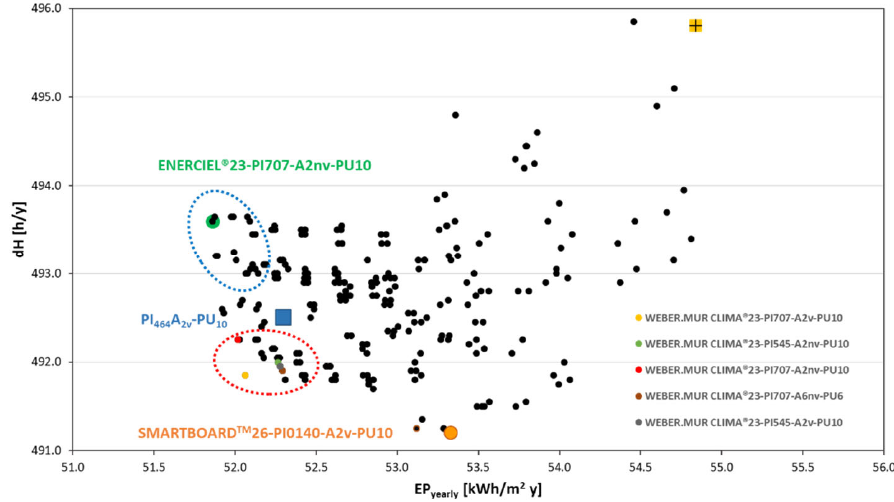
Figure 7. PCMs on internal side: comparison based on primary energy need and discomfort hours.